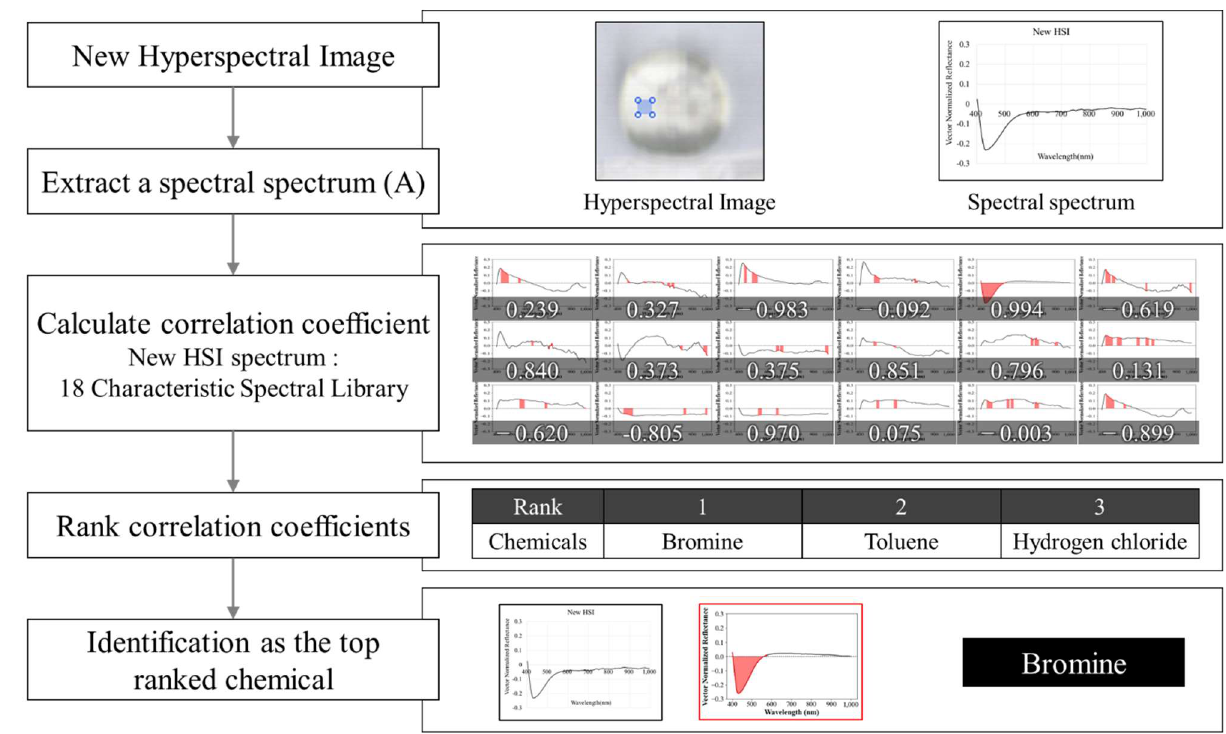
Figure 11. Chemicals recognition concept using a characteristic spectral library.